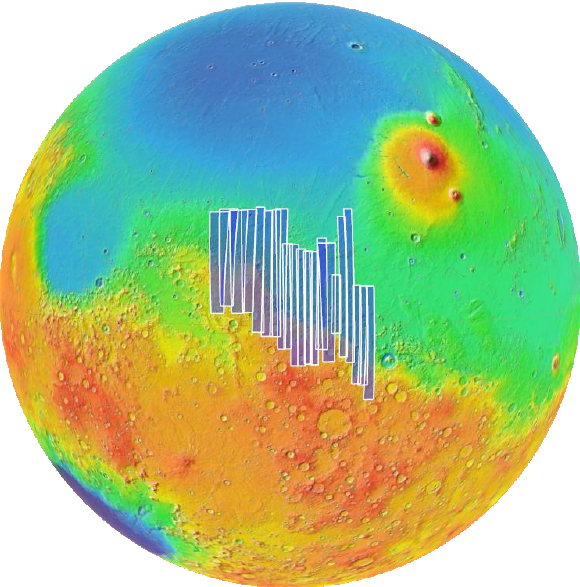
Figure 1: Color coded MOLA DTM with footprints of 21 HRSC nadir channel images constituting a photogrammetric